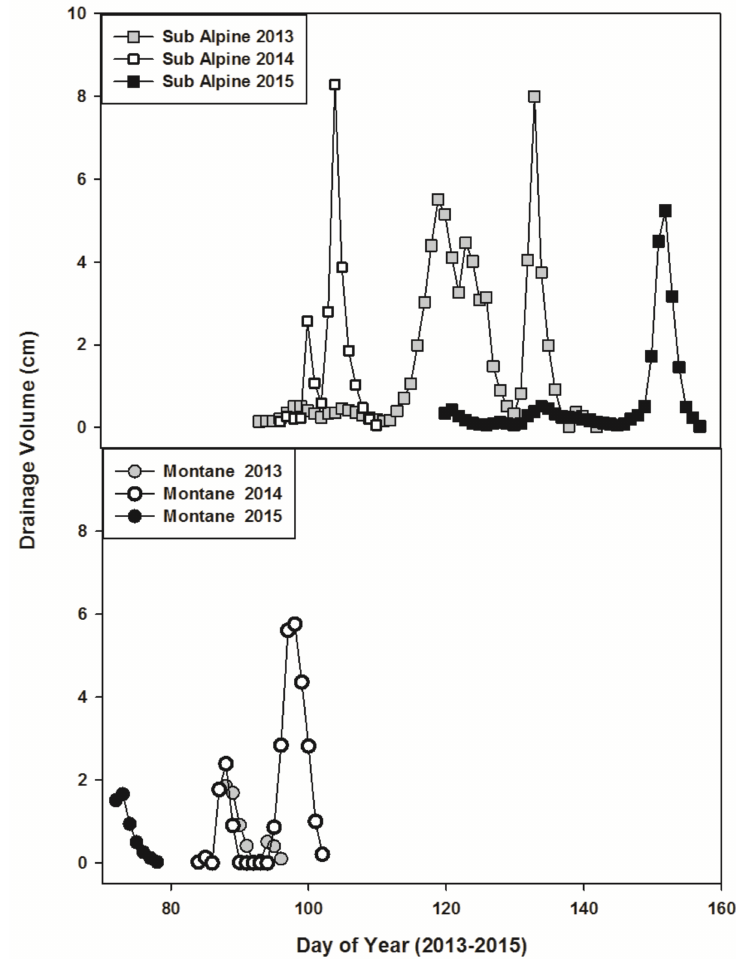
Figure 3. Drainage volume at the Montane West and Subalpine West sites during 2013–2015. Drainage was recorded on an hourly basis with peak drainage measured at 0.92 cm h − 1 at the Subalpine West site and 1.03 cm h − 1 at the Montane West site in 2014. These maximum values represented only 3.9% of the saturated soil hydraulic conductivity measured with intact cores taken at the sites (2.64 ± 1.48 cm h − 1 Sagebrush, 5.69 ± 1.18 cm h − 1 Pinyon Juniper West, 26.34 ± 5.64 cm hr − 1 Montane West and 23.69 ± 6.75 cm hr − 1 Subalpine West), indicating that even immediately after snowmelt, flow never approached saturated flow conditions. We did not assess interflow; however, slopes were all less than 12%, average saturated hydraulic conductivities in the surface horizon at the two higher elevations were greater than 23 cm h − 1 , no compacted restrictive layers were observed with depth except at the lower Sagebrush site and no flow was observed in down gradient washes in close proximity to the flux meters. Instead what we observed was that 80 percent of the variation in the drainage at the two highest elevations could be described by the total annual precipitation and the average December-March soil temperature at 10 cm, with higher drainage associated with higher precipitation and warmer soil temperatures (Drainage = − 95.43 + 2.81 (Precipitation) + 63.3 (Soil Temp), R 2 = 0.82 p < 0.05). At the Subalpine West site, a very high drainage volume was measured in 2013 (~70 cm), associated with a 27–34-day earlier occurrence of drainage with mean soil temperatures at 10 cm in March equaling 0 ◦ C, whereas average monthly soil temperatures ≥ 0 ◦ C did not occur until May in 2014 and April in